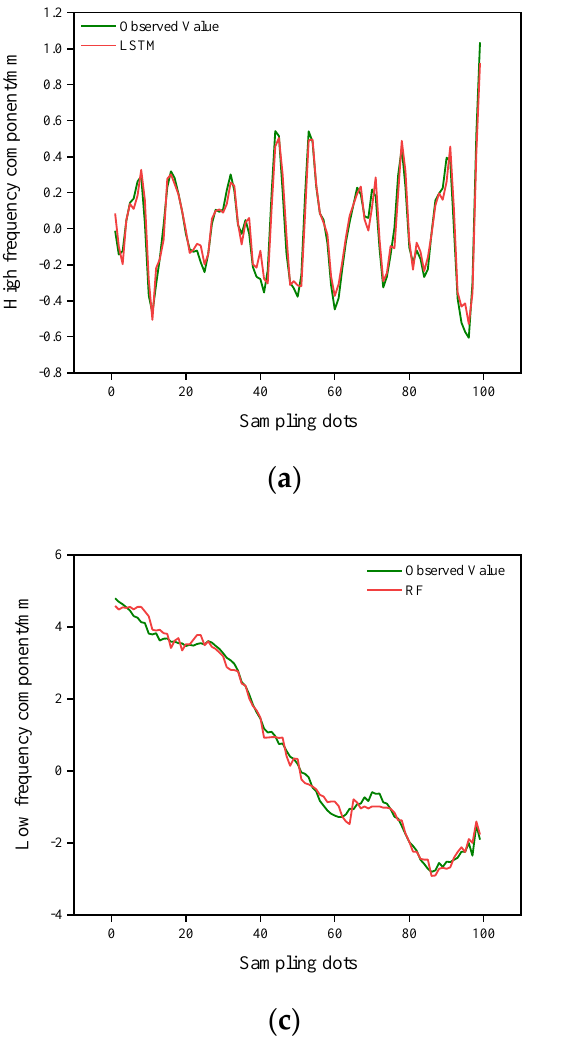
Figure 9. Measurement point EX5 high and low frequency prediction and correlation coefficient. (( a ) High frequency prediction; ( b ) Linear regression analysis of LSTM; ( c ) Low frequency prediction; ( d ) Linear regression analysis of RF). Table 5. Comparison of evaluation indexes of measuring point